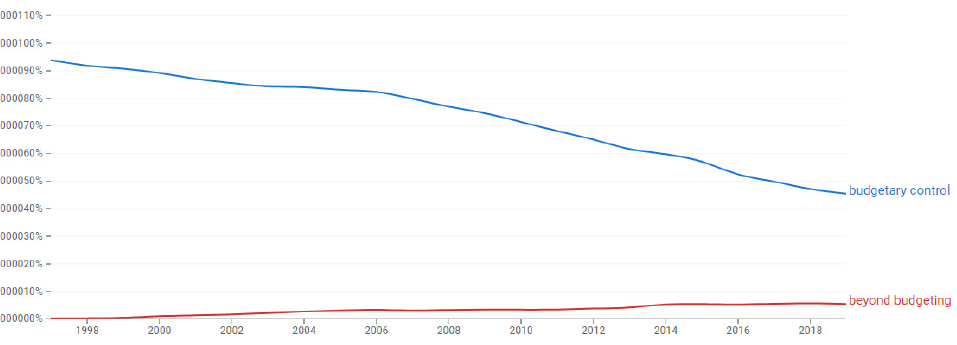
Figure 3. Evolution of the terms “budgetary control” and “beyond budgeting” (Data source: Google Books Ngram Viewer, available at http://books.google.com/ngrams, retrieved 25 August 2022).